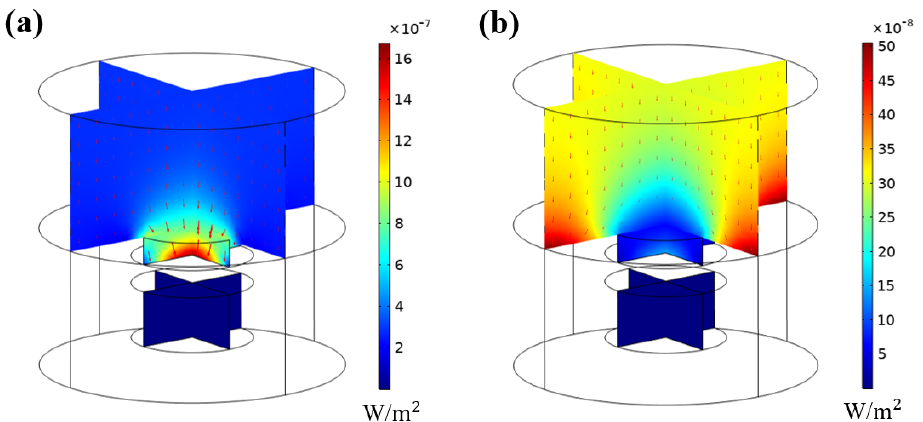
Figure 12. Acoustic intensity distributions for the hybrid sound-absorbing metastructure at ( a ) 3.1 and ( b ) 5.5 kHz.